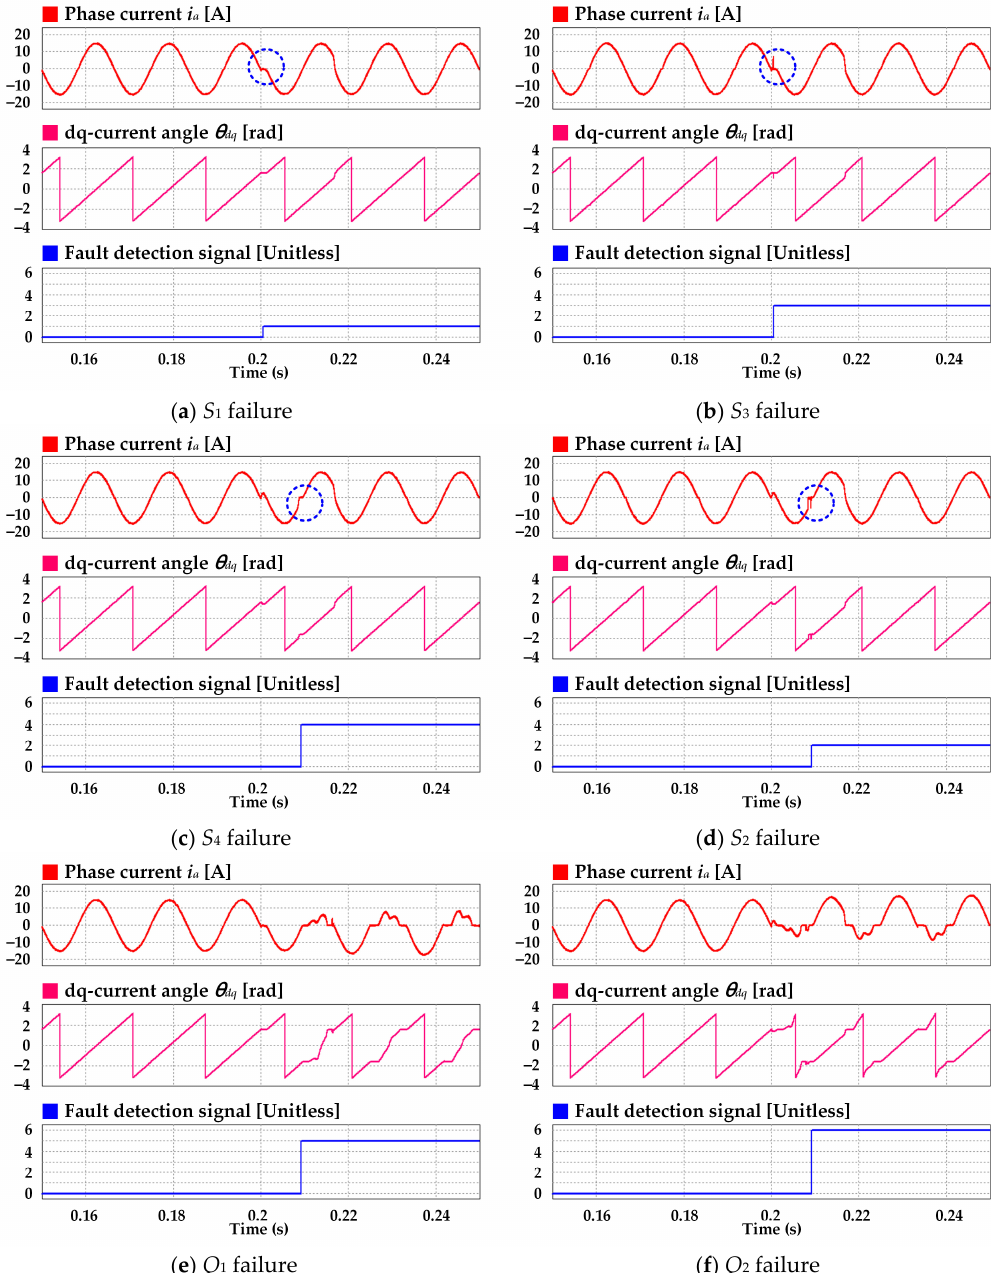
Figure 14. Simulation waveforms of phase current, current angle, and fault detection signals for each switch failure in the HANPC rectifier.